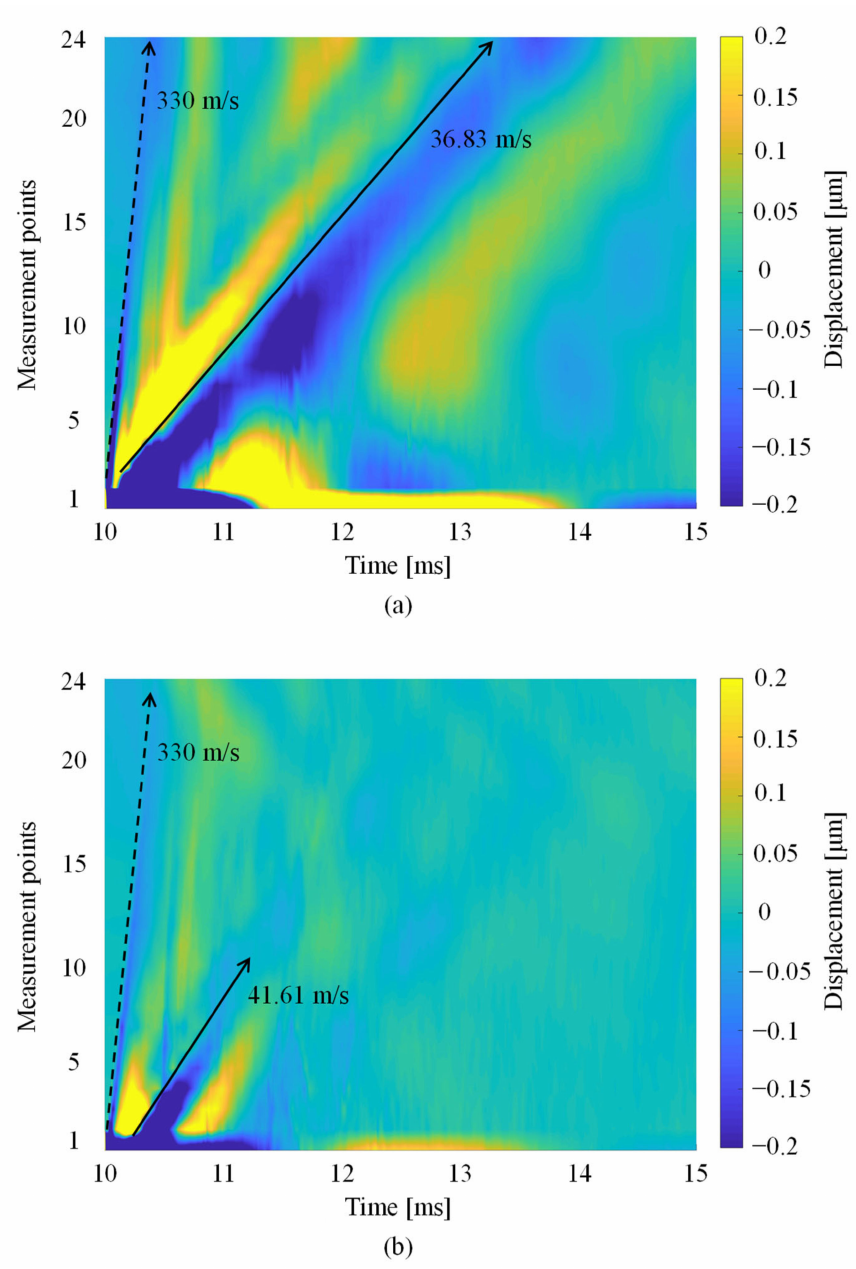
Figure 10. Rayleigh wave propagation on mango 12 at 0 h. ( a ) Line A where the measurement points are on the equator, ( b ) Line B where the measurement points are orthogonal to the